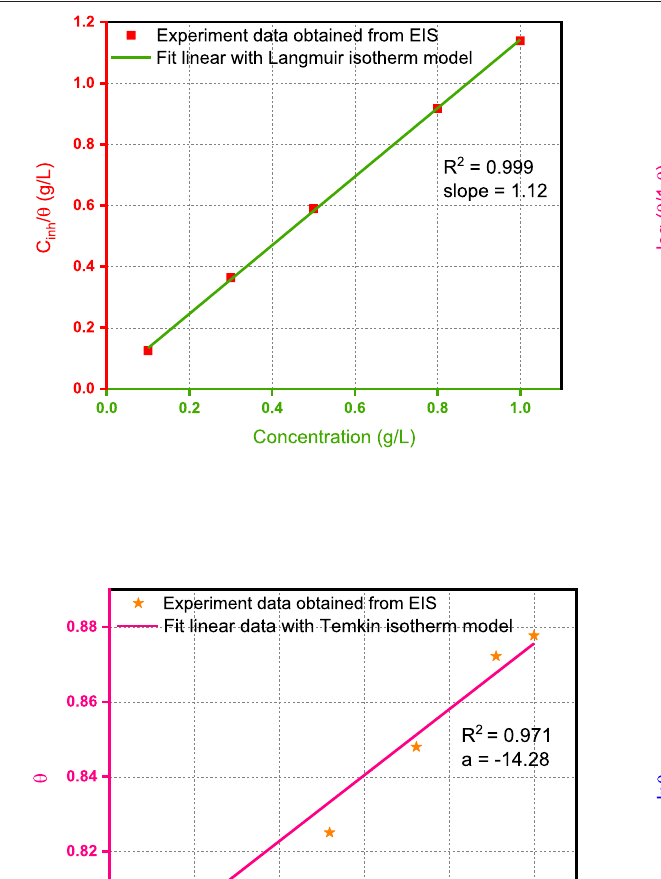
FIGURE 7 | Plots of models of the adsorption isotherm of Wf-EO for MS surface in 1.0 M HCl at 298 K obtained from EIS data.